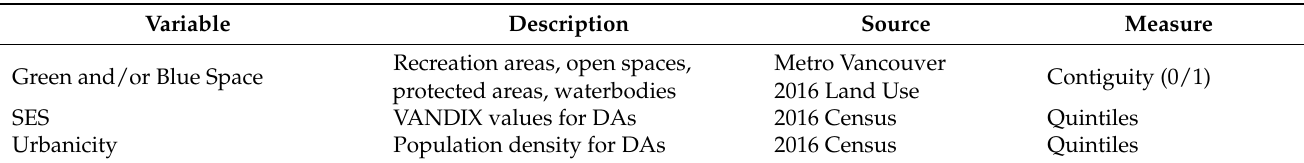
Table 1. Neighborhood